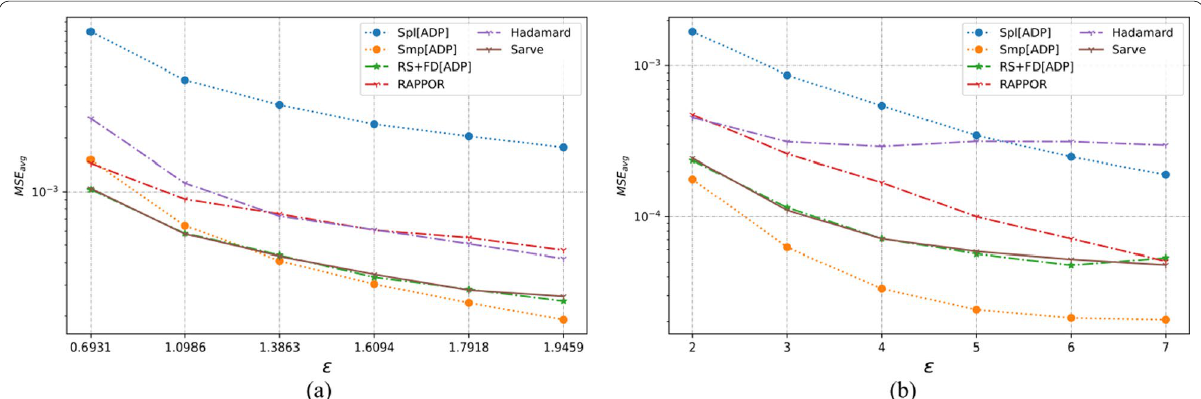
Fig. 5 The MSE averaged over 100 runs for the UCI adult dataset privatized using different randomization techniques and fake data under a high privacy regime, experimental setup labeled ES_Real_1 in Table 1; b general privacy regime, experimental setup labeled ES_Real_4 in Table 1